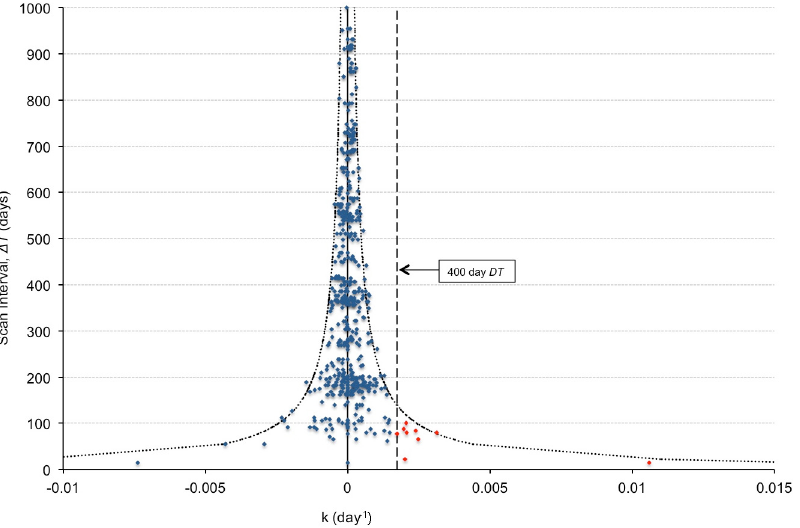
Fig 5. Plot of stable nodule k (growth rate) estimates for all non-calcified nodules as a function of scan interval, Δ T . The estimated FPR is 1.6% (9/579), as computed by k > 0.00173 day -1 (i.e. DT < 400 days) (horizontal dashed line). There were no false positive results for a scan interval greater than 100 days. Note the decreasing error in k with increasing scan interval time. The border curves ( ⦁⦁⦁⦁⦁ ) represent ± 3 σ k , as determined from Eq 4 in the Appendix, with a = 0.057 as calculated in Fig